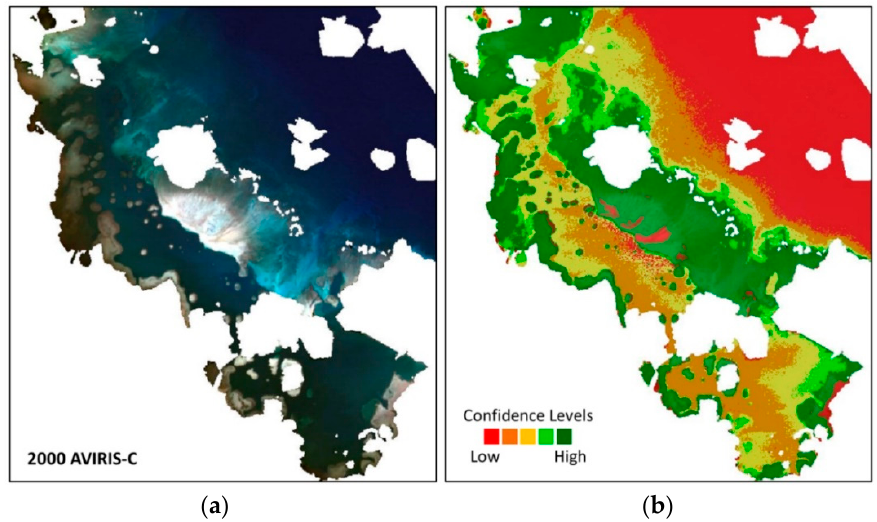
Figure 7. Example of applying confidence level thresholds to 2000 Kaneohe Bay AVIRIS-C data at 18 m spatial resolution: ( a ) True-color image; ( b ) confidence levels as semi-transparent overlay on true-color image. Areas with no data and masked areas of land, cloud, cloud shadow, and wave breaks are shown in white.